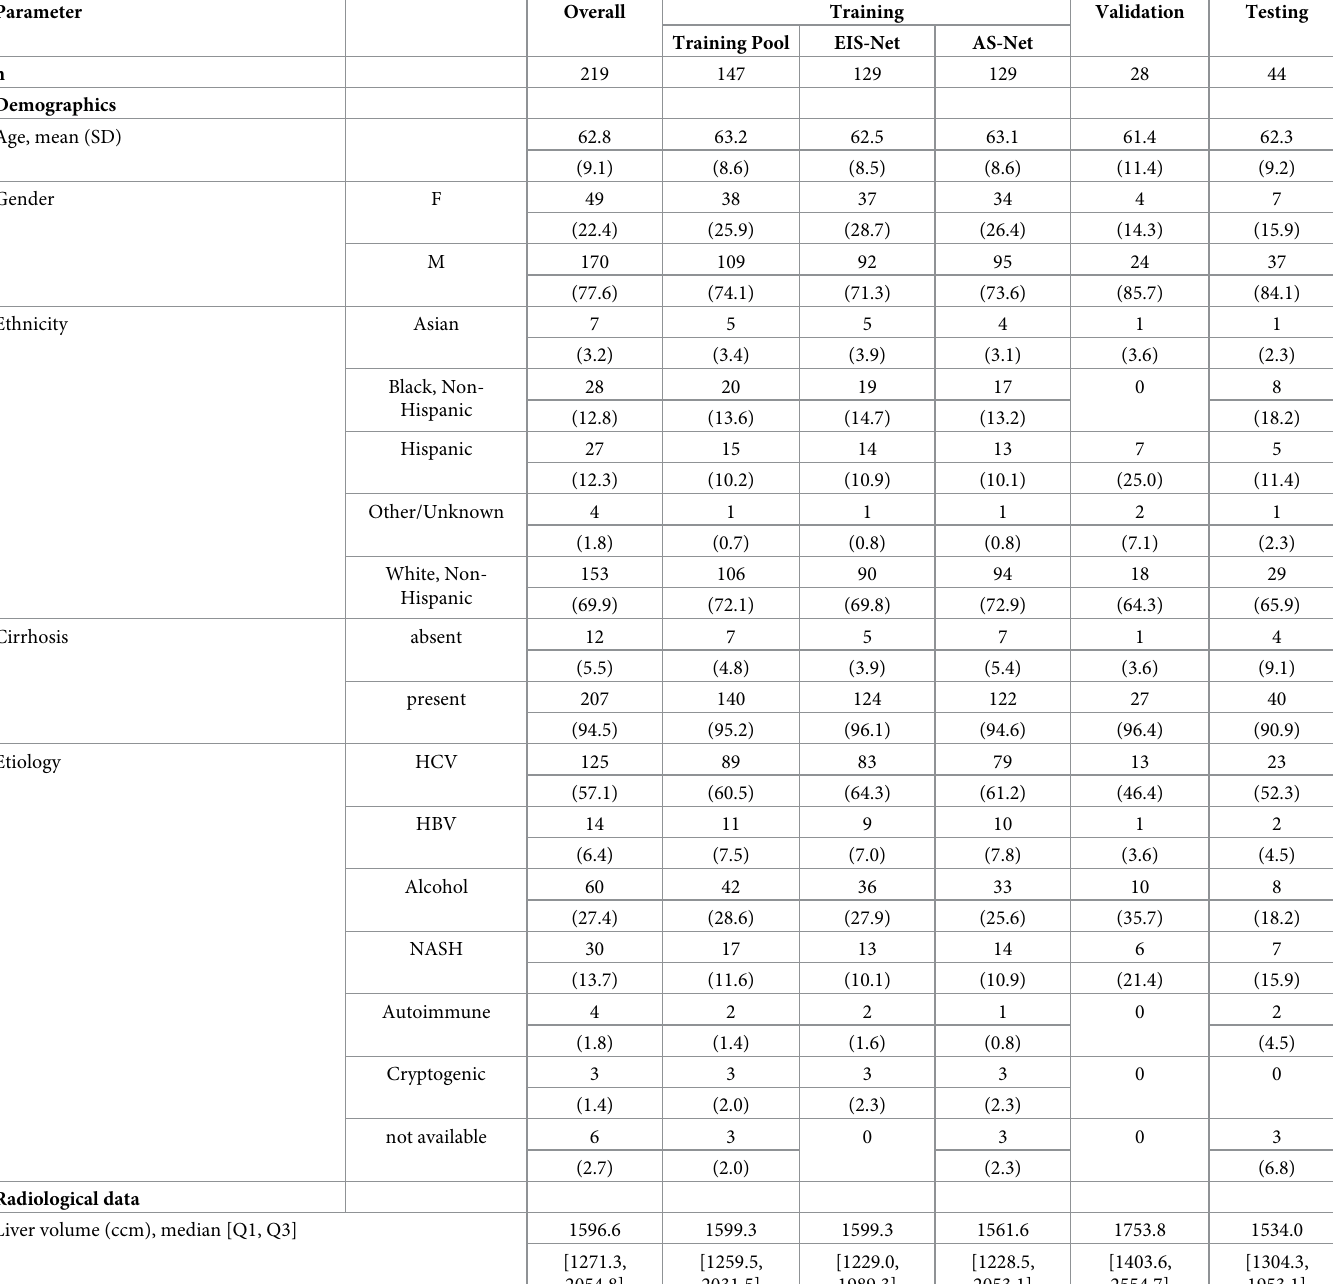
Table 1. Demographic, radiological, and cancer staging sample statistics of the training, validation, and testing cohorts from 219 HCC patients included in this study.